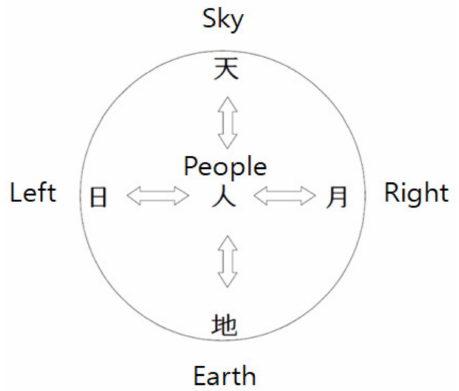
Figure 1. 天 地 人 日 月 圖 : The meaning of the epidemiological spatial structure of Korea Dance, (Choen Ji In Il Wol Do: spatial structure—sky ( 天 ), earth ( 地 ) and people ( 人 ), temporal structure: left ( 日 ), right ( 月 ); interacting in a state of harmony and balance, creating movement of motion) states that humans who respond to the sky above and the earth below interact with heaven, the earth and all